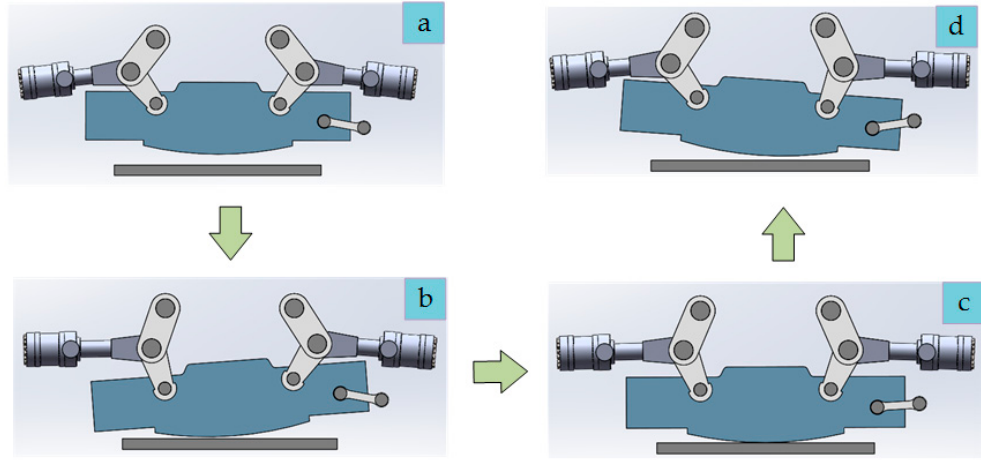
Figure 2. Work cycle of a rolling shear: ( a ) the initial state; ( b ) the beginning of the cutting process; ( c ) cutting being performed; ( d ) the end of the cutting process.